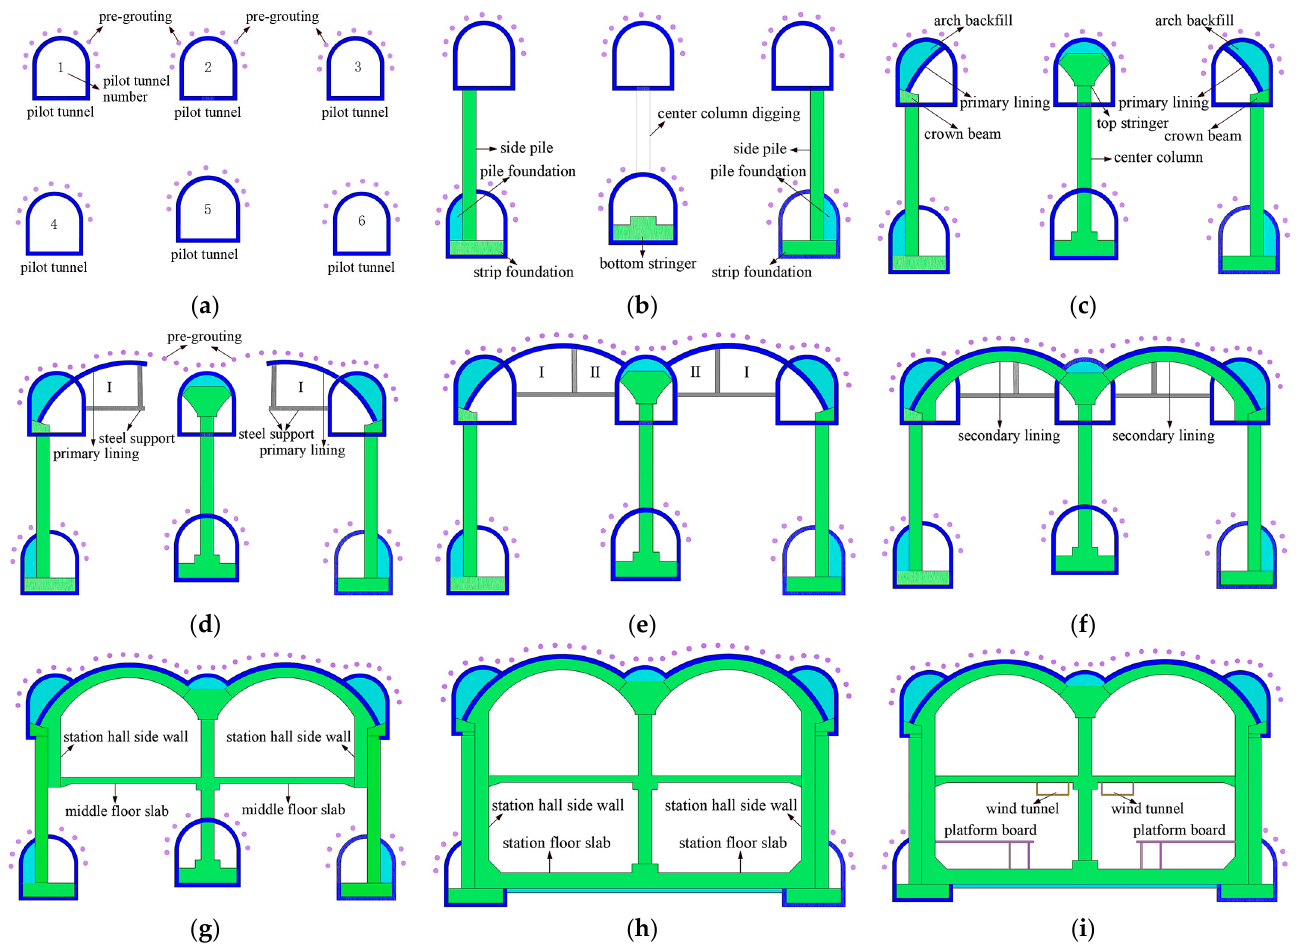
Figure 5. Schematic of the main construction process of Qinghuadongluxikou Station: ( a ) stage 1; ( b ) stage 2; ( c ) stage 3; ( d ) stage 4; ( e ) stage 5; ( f ) stage 6; ( g ) stage 7; ( h ) stage 8; ( i ) stage 9.